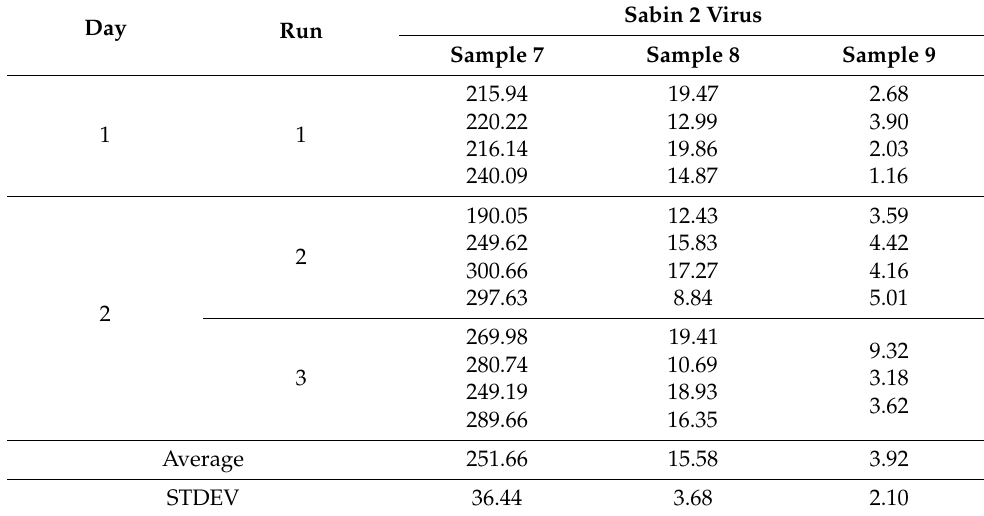
Table 2. Analysis of repeatability of results generated by the qosRT-PCR Sabin 2 contamination assay.